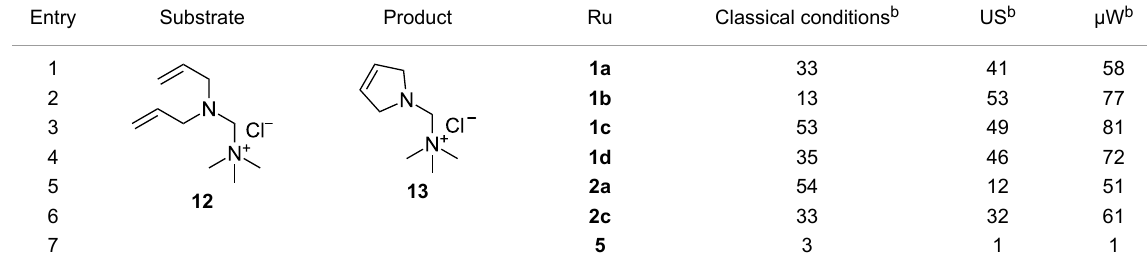
Table 3: Effect of the size of the NHC ligand in the catalysts 1a , 2a , and 3a on their catalytic efficiency in the RCM of substrate 6 under μ W and US ir- radiation. a